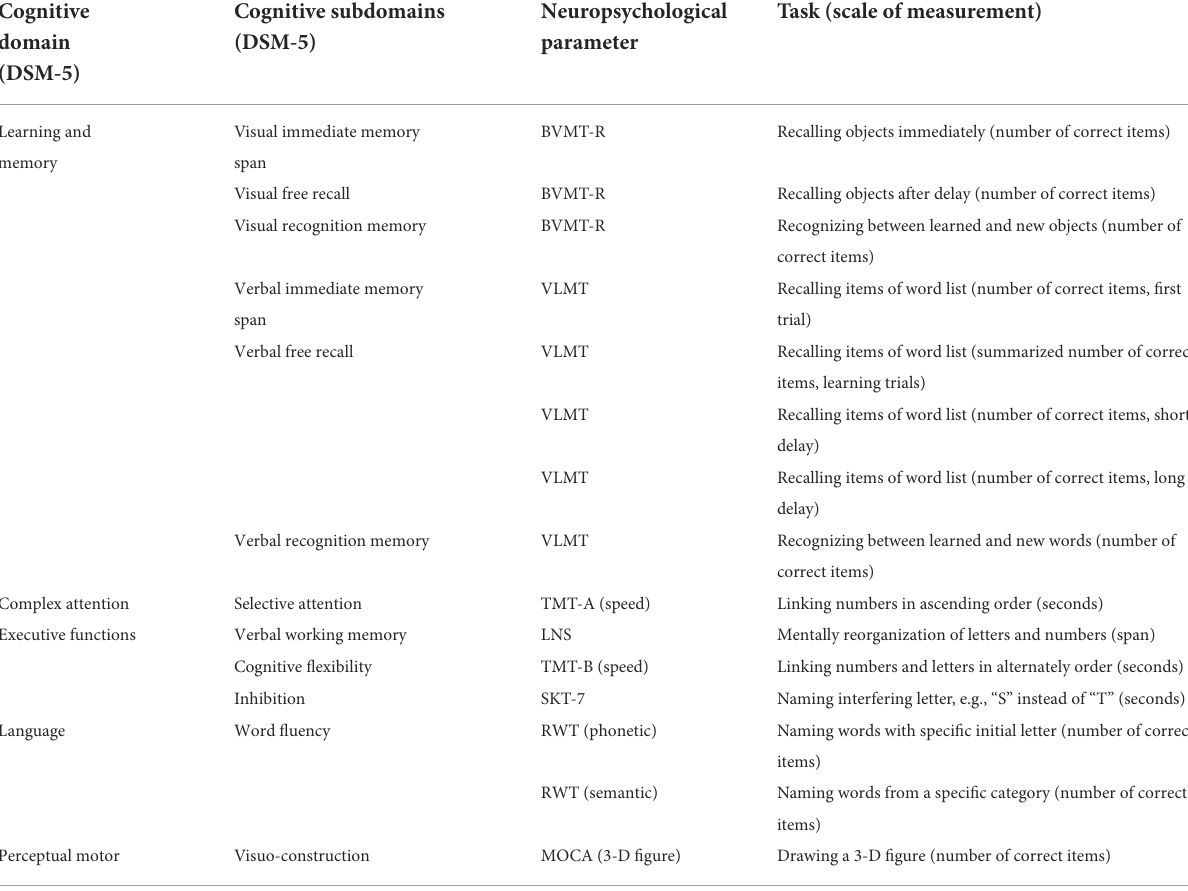
TABLE 2 Definition of neuropsychological parameters and cognitive subdomains.